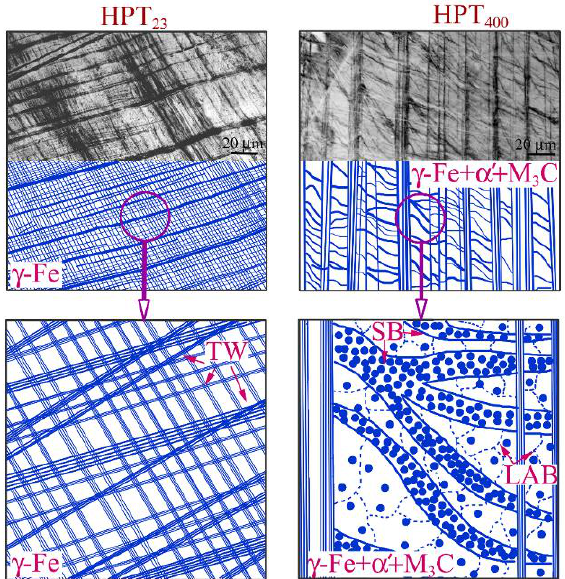
Figure 8. A schematic illustration of the di ff erences in microstructure of HPT 23 and HPT 400 specimens. TW — twin boundaries, SB — shear bands, LAB — low-angle boundaries.